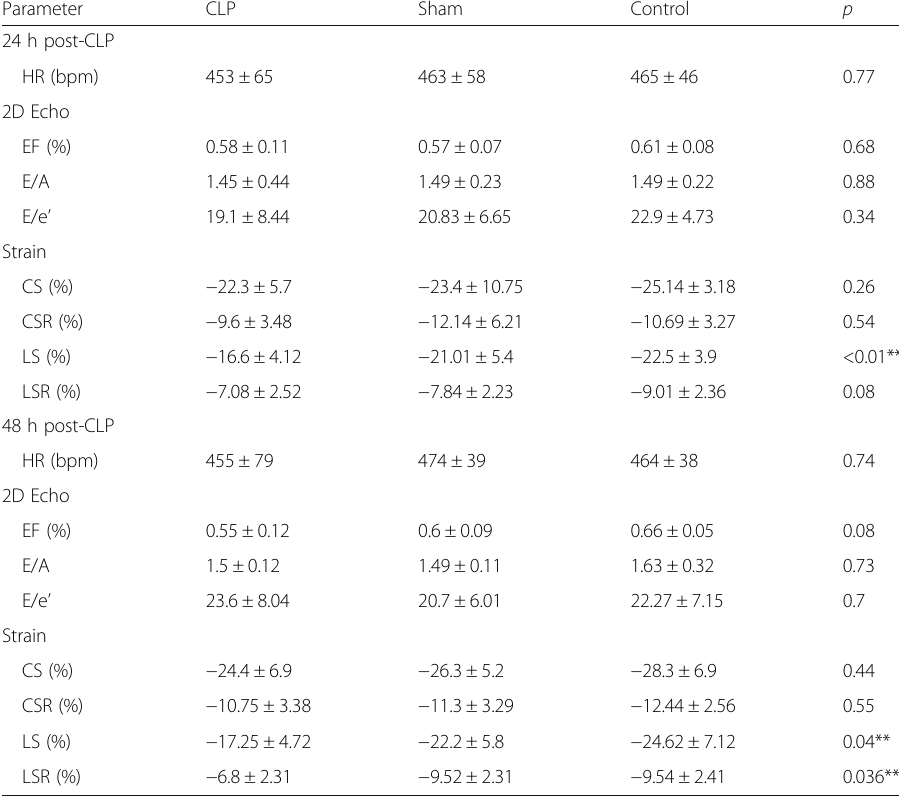
CLP indicates cecal ligation and puncture, CS global circumferential strain, CSR peak systolic circumferential strain rate, E/A , ratio of peak flow velocity across the mitral annulus during early and late diastole, 2D Echo conventional echocardiography, E/e ’ ratio between mitral inflow and mitral annular excursion velocity during early diastole, EF ejection fraction, LS , global longitudinal strain, LSR peak systolic longitudinal strain rate Strain strain echocardiography. **CLP group is significantly different versus sham and control